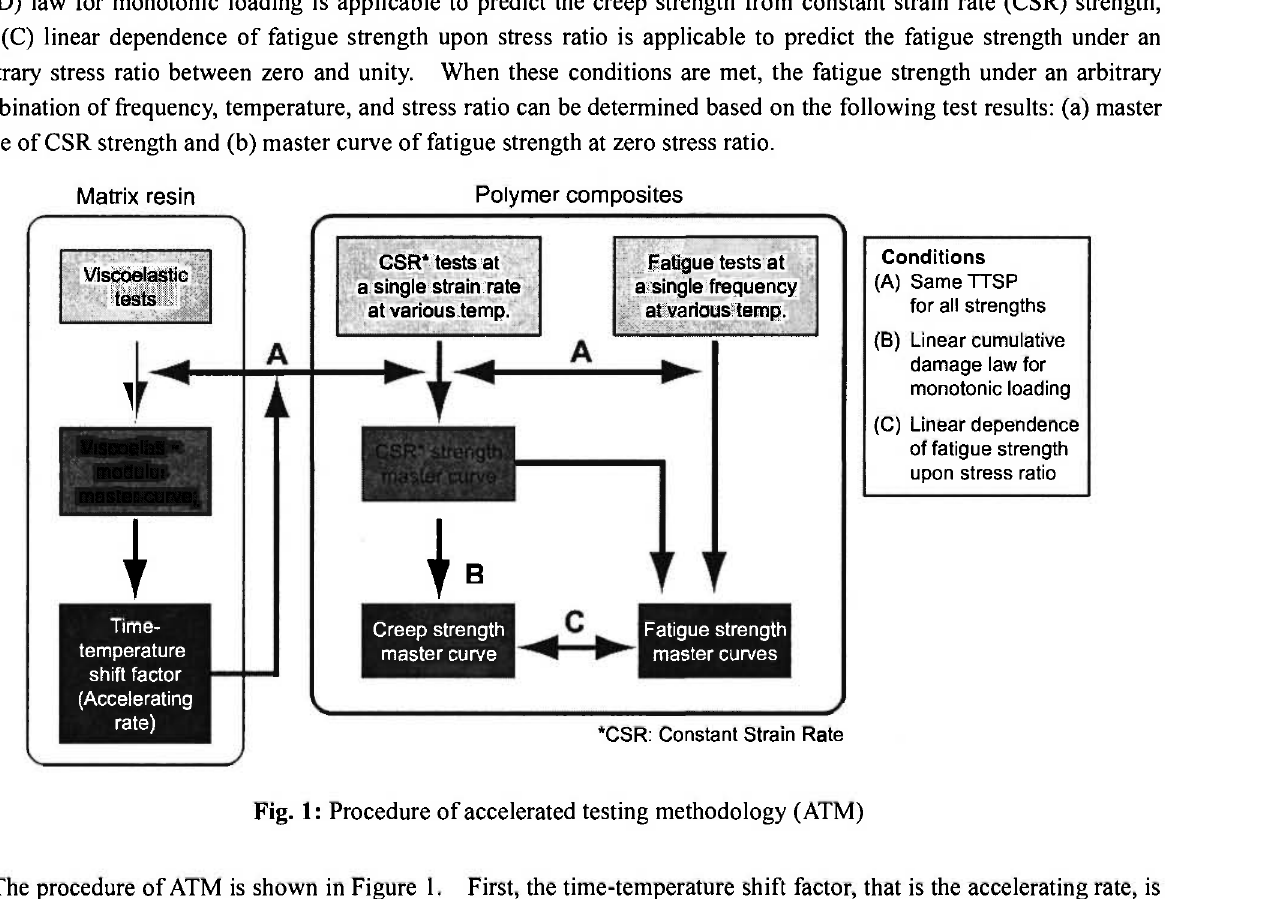
Fig. 1 : Procedure of accelerated testing methodology